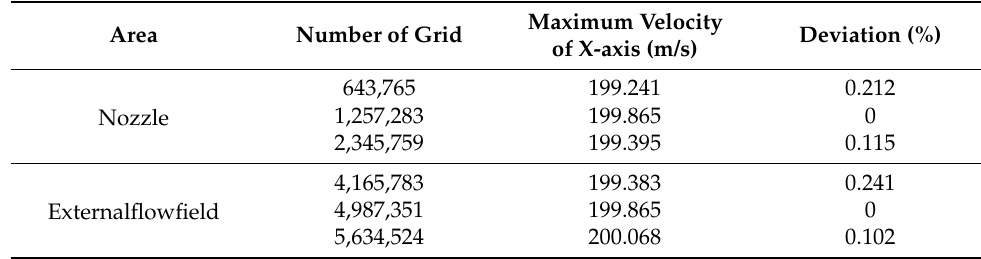
Figure 4. Simulation Model of Flow Field: ( a ) structured grid of flow field; ( b ) detail view of structured grid. Table 1. Verification of grid